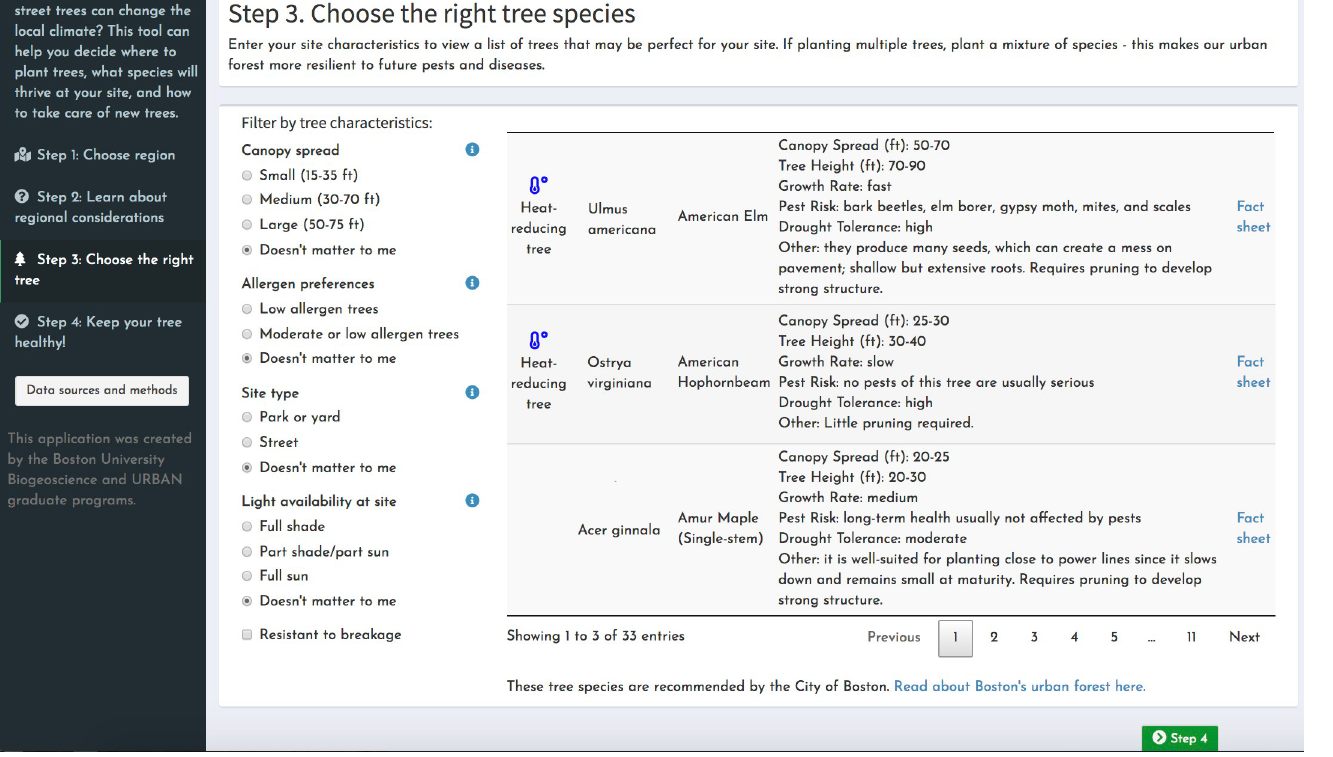
Fig 3. “Step 3: Choose the right tree species”. The third page of the tool allows for the user to use preferences and hyper-local site characteristics to filter a list of tree species approved by the City of Boston. Choices can be selected on the left and the trees that meet all specifications appear to the right. Each listing includes a small image, basic size and growth information, a link to a full fact sheet, and an icon that indicates if a tree has particularly high potential for heat-reduction (based on transpiration rates and leaf area).